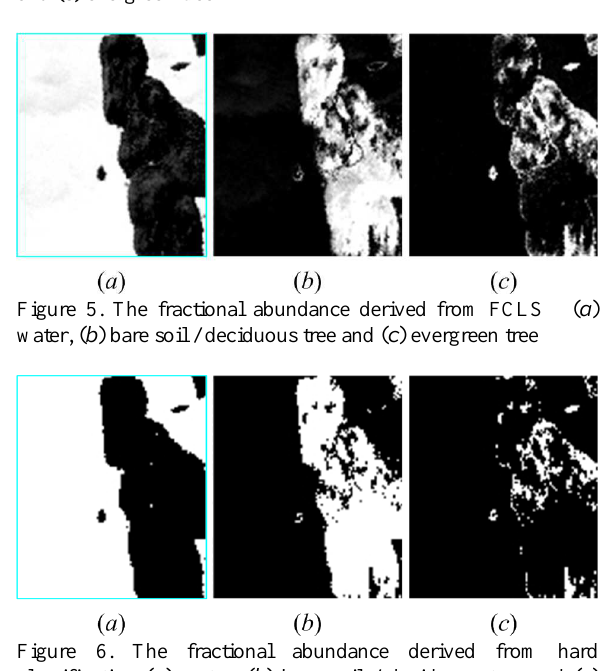
Table 1. RMSE values of different spectral unmixing